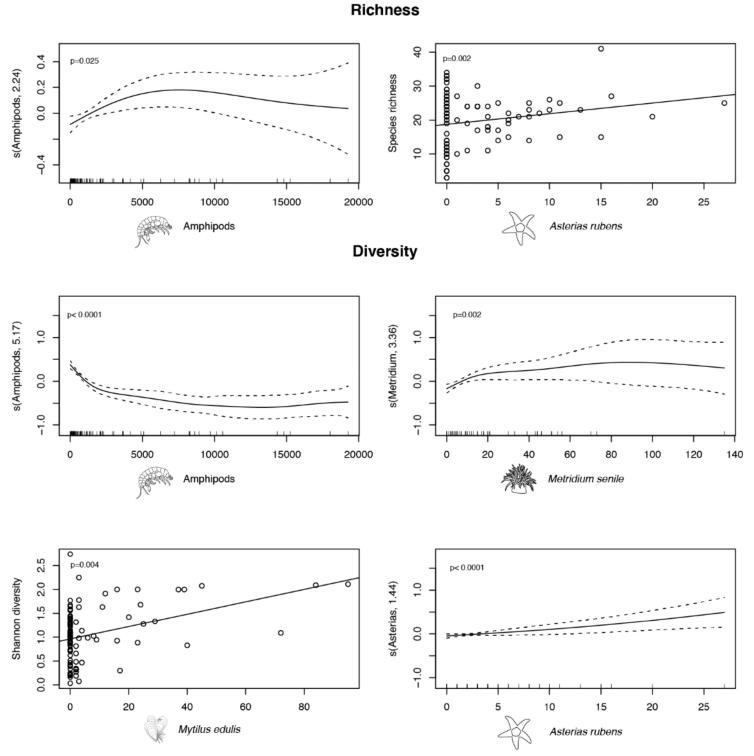
Figure 5. Fitted relationship for significant biological predictors in the best-fitting generalized additive model explaining richness and diversity from offshore wind farms. Richness is significantly